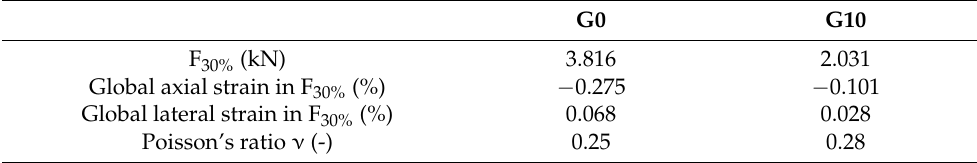
Table 3. Poisson’s ratio values for samples G0 and